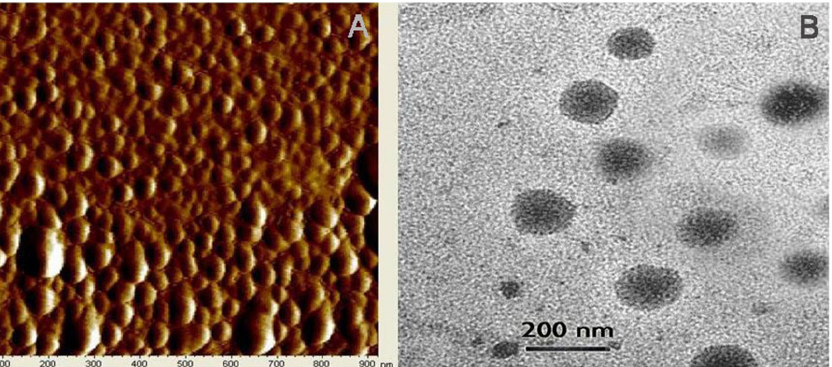
Figure 1. Shape and surface morphological of CSbnp. Atomic force microscopy of CSbnp (A) and transmission electron microscopy of CSbnp (B).